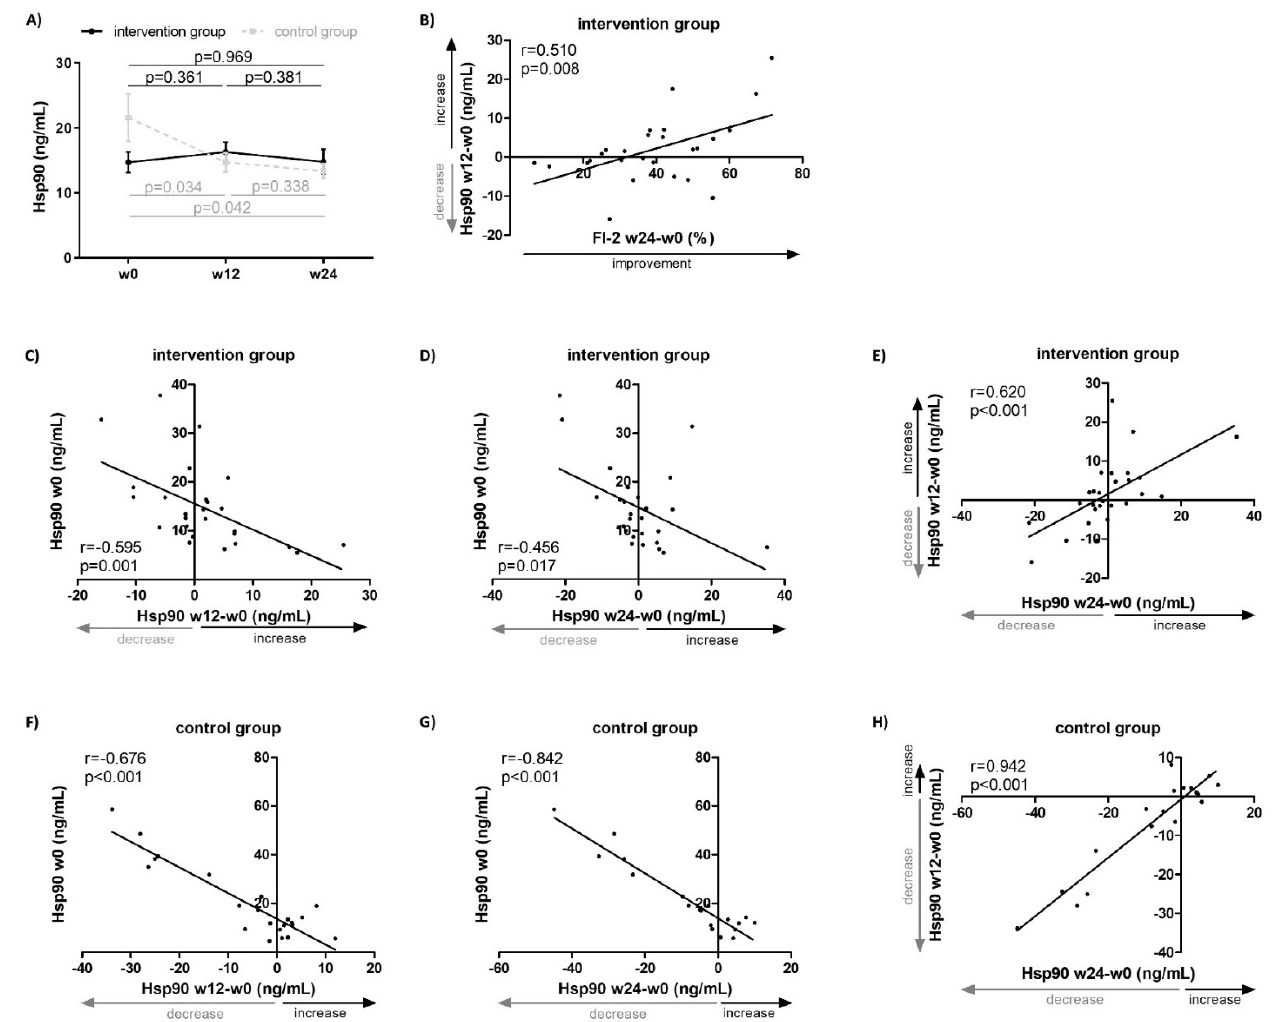
Figure 1. Plasma Hsp90 levels in patients with idiopathic inflammatory myopathies treated with standard-of-care pharmacotherapy (control group, CG, n = 23) or with additional non-pharmaco- logical intervention (intervention group, IG, n = 27) for 24 weeks. ( A ) Differences in plasma Hsp90 levels over 24 weeks in both IG and CG (lines represent the mean, whiskers represent the standard error of the mean). ( B ) An increase in plasma Hsp90 levels over 12 weeks predicted an improvement in muscle endurance assessed by Functional Index-2 (FI-2) over the entire 24-week intervention. Lower baseline plasma Hsp90 levels in IG predicted an increase in plasma Hsp90 over weeks 0–12 ( C ) and 0–24 ( D ). ( E ) An increase in plasma Hsp90 levels over weeks 0–12 in IG predicted an increase in plasma Hsp90 over weeks 0–24. Higher baseline plasma Hsp90 levels in CG predicted a decrease in plasma Hsp90 over weeks 0–12 ( F ) and 0–24 ( G ). ( H ) A decrease in plasma Hsp90 levels over weeks 0–12 in CG predicted a decrease in plasma Hsp90 over weeks 0–24. W, week.